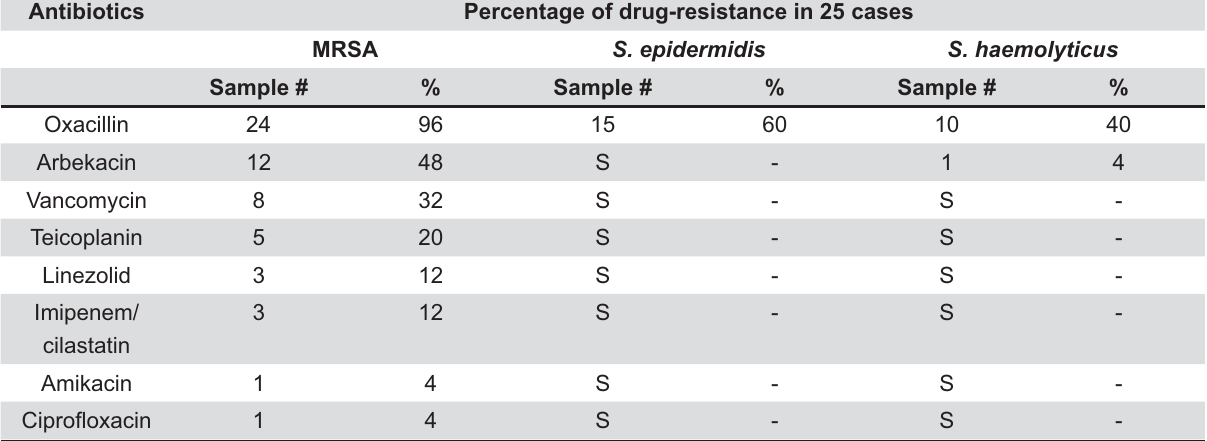
Table 4- Prevalence of bacterial species against respective antibiotics